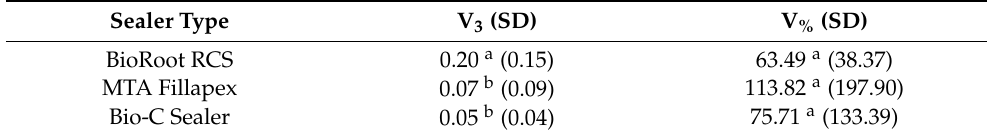
Figure 3. Voids volume after SGPC obturation with different CSBSs before (V1) and after (V2) storage with the volume of change (V3). (*) indicates statistically significant difference ( p ≤ 0.05). The highest change in the voids volume (V3) was in BioRoot RCS (0.20 mL ± 0.15), followed by MTA Fillapex (0.07 mL ± 0.09), and the least was found in Bio-C Sealer (0.05 mL ± 0.04). These differences were statistically significant using the Kruskal–Wallis test ( p < 0.05) (Table 3). Table 3. The mean change in voids volume (V3) and mean percentage of change (V%) for each sealer after storage.